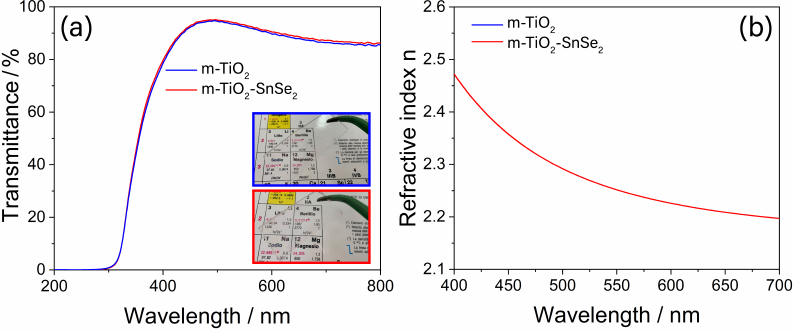
Figure 4. ( a ) UV-Vis spectra and refractive index ( b ) of m-TiO 2 film (blue line) and m-TiO 2 -SnSe 2 film (red line). The two curves overlap. The inset in ( a ) shows the snapshots of the films deposited on silica glass